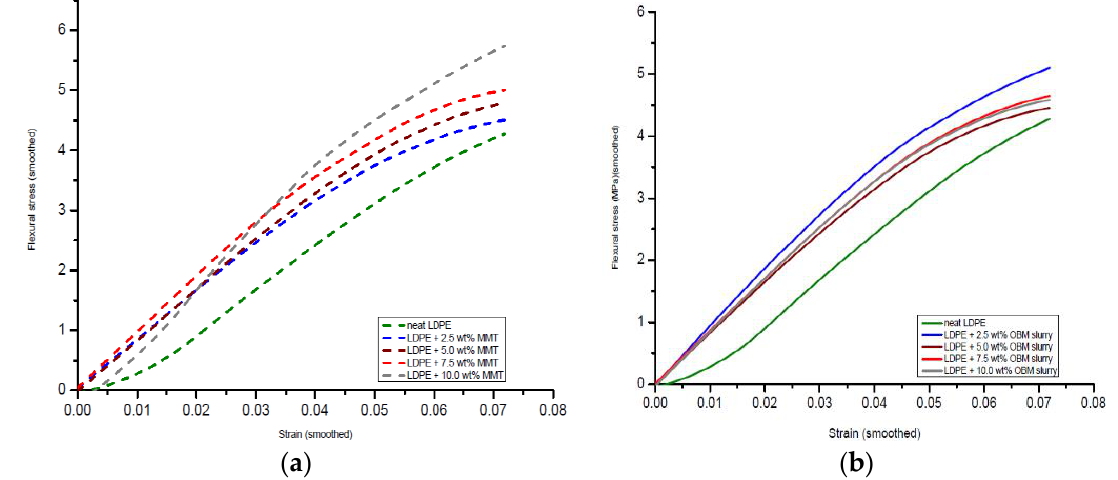
Figure 12. Flexural stress–strain curves from three-point bend test of ( a ) neat LDPE, LDPE/MMT and ( b ) LDPE/OBM slurry nanocomposites.